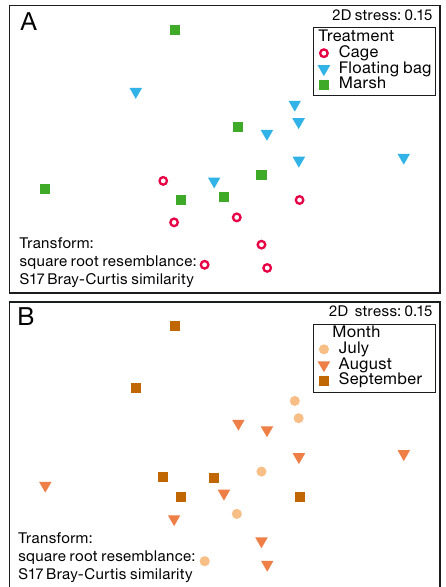
Fig. 3. Non-metric multidimensional scaling plots of nekton community based on MaxN calculated from each 80 min video for each species (n = 21), with overlays of (A) habitat treatment type and (B) sampling